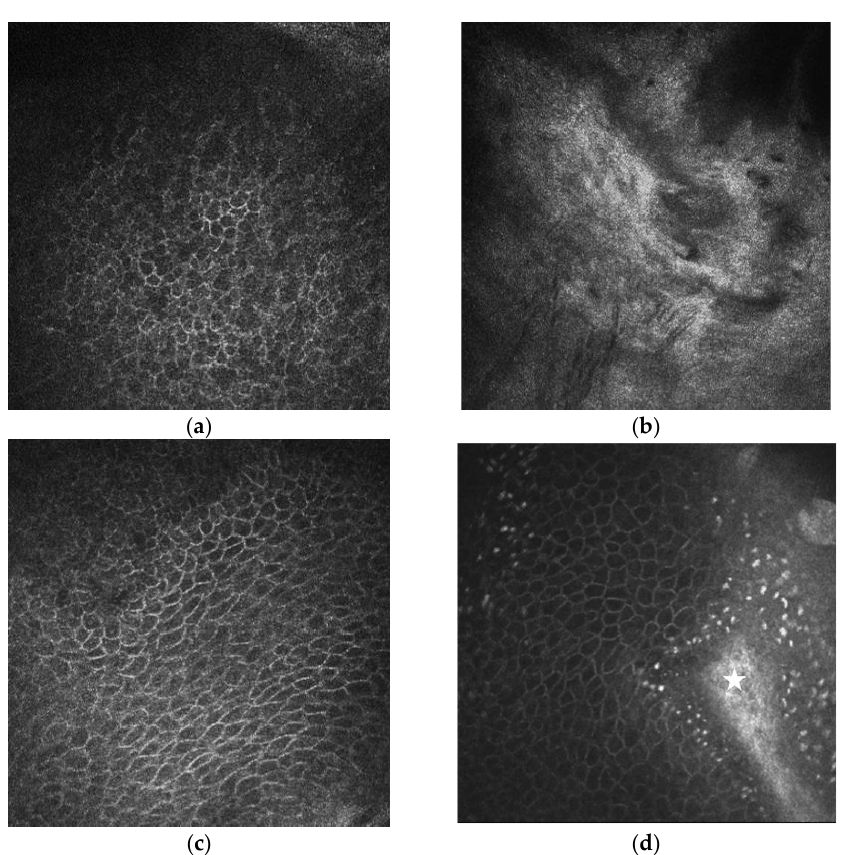
Figure 5. In vivo confocal microscopy of the patient with partial unilateral LSCD. ( a ) Confocal image of epithelial basal cells at the central cornea of the LSCD-affected eye. Wing cells are